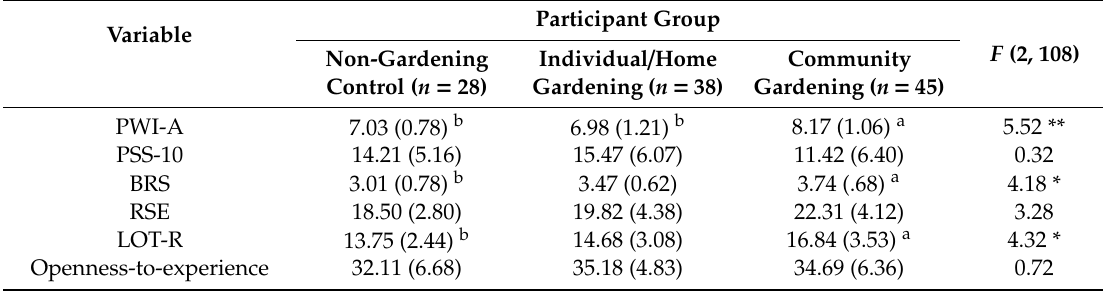
Table 3. Means (SD) of Study Variables and MANCOVA Results of Di ff erences Across Three Groups While Controlling for Age and Inclusion of Nature in Self (INS)